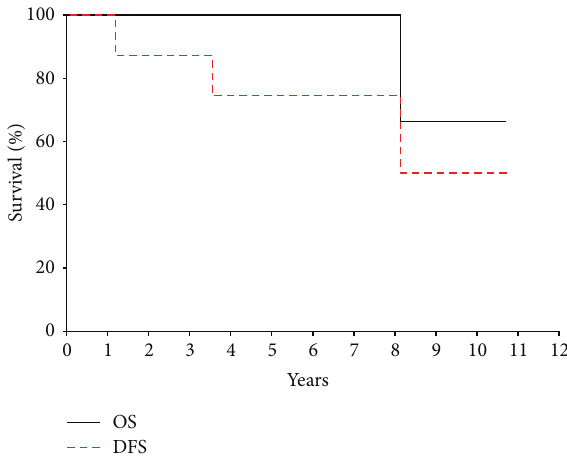
Figure 2: Overall survival (OS) and disease-free survival (DFS) for patients with mesenchymal chondrosarcoma presenting with localized disease at